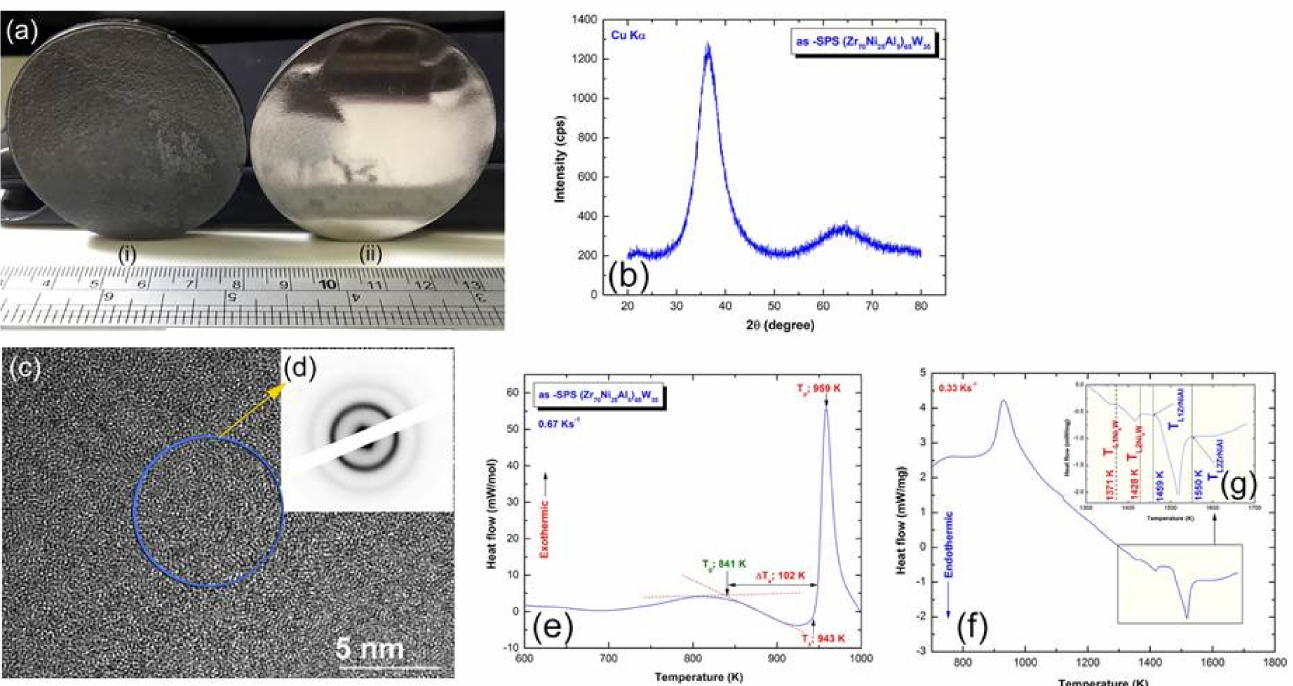
Figure 12. ( a ) Photos of the as-SPS 50 mm (Zr 75 Ni 25 Al 5 ) 65 W 35 metallic glassy system before ( i ) and after ( ii ) polishing. The XRD pattern, HRTEM image with NBDP, DSC thermogram, and DTA trace of the consolidated powders are presented in ( b ), ( c , d ), ( e ), and ( f , g ),